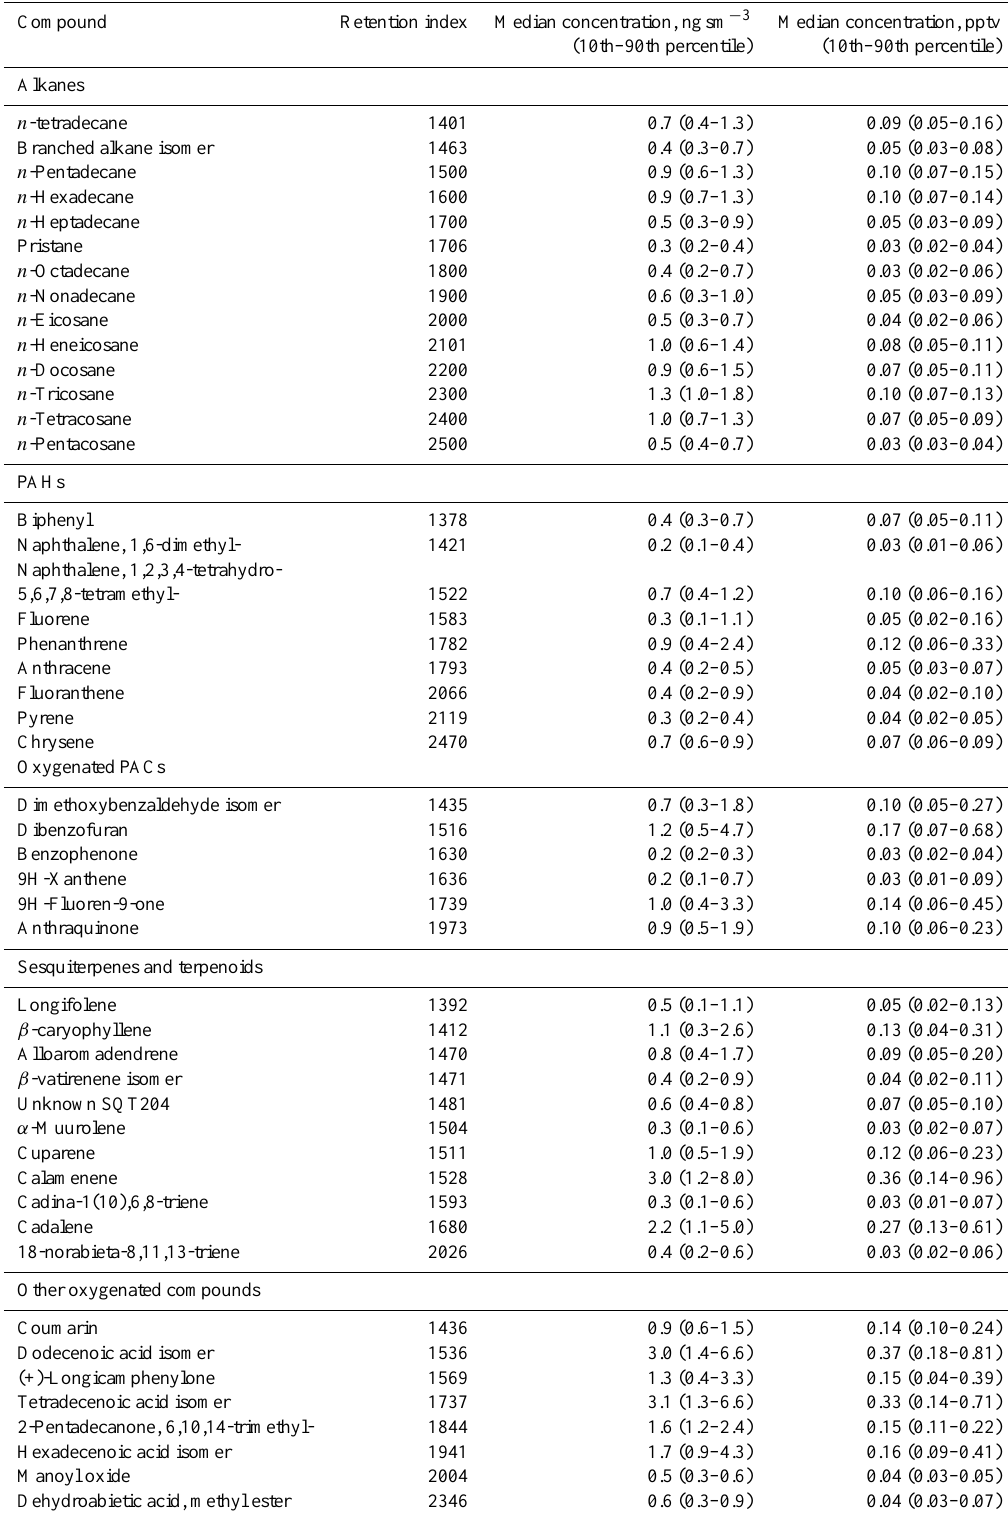
Table 1. A partial list of compounds measured during BEACHON-RoMBAS 2011. A full list of identified compounds and comparison to literature retention indices are shown in the